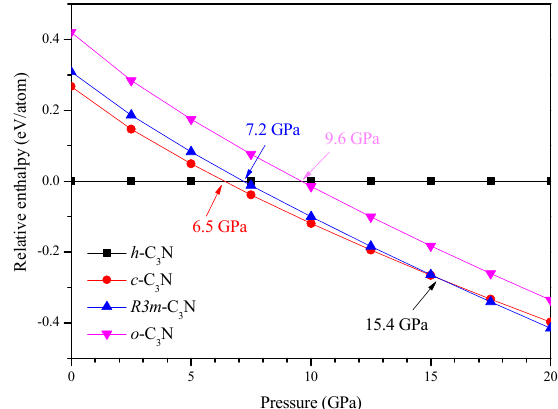
Figure 2. Enthalpies differences of c -C 3 N, R 3 m -C 3 N, and o -C 3 N relative to h -C 3 N as a function of pressure.